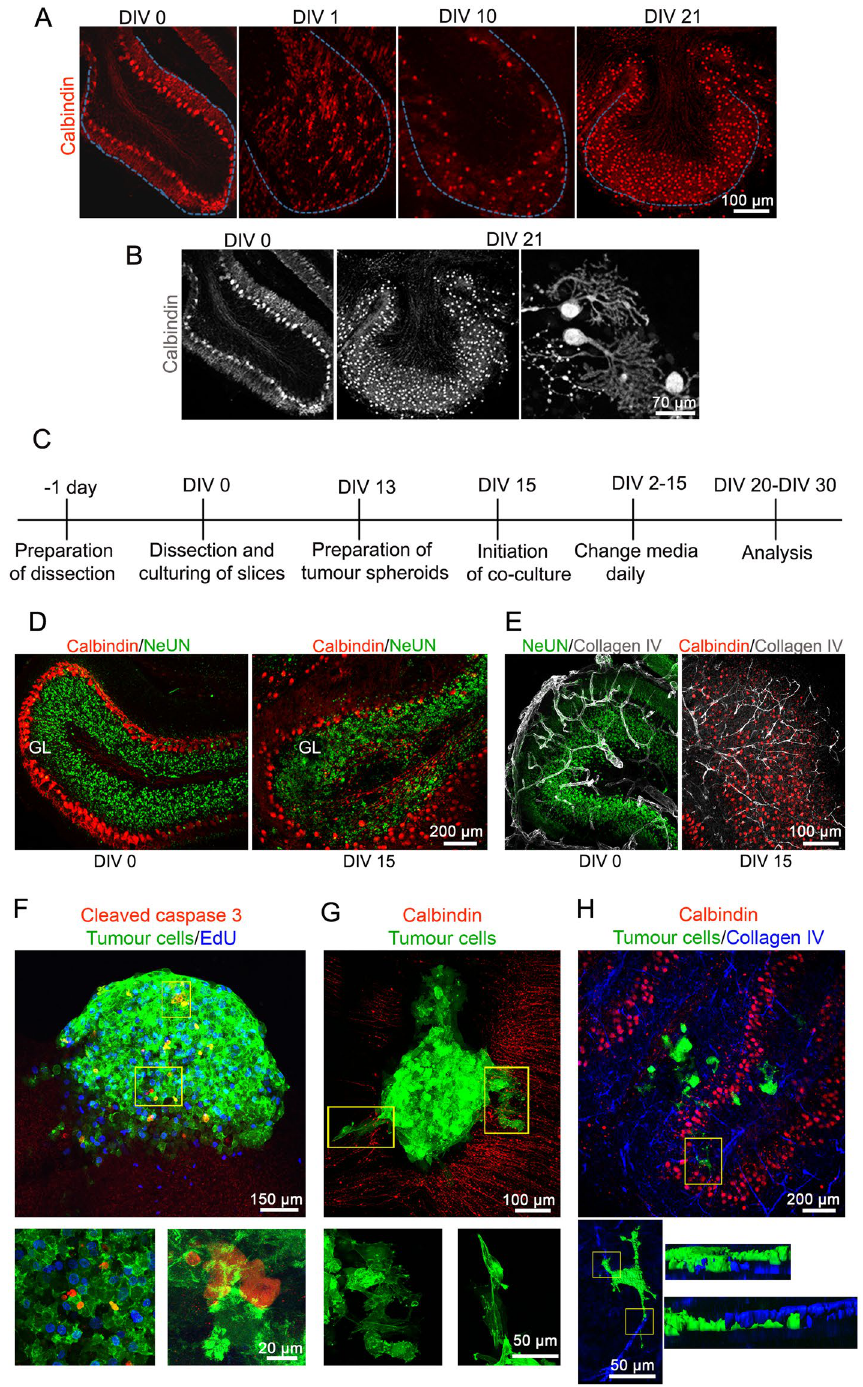
Figure 2. Morphological assessments of the cerebellar slices and co-culture in vitro . ( A) Changes in the Purkinje cell monolayer upon in vitro culturing of the slices was monitored at DIV 0, DIV 1, DIV 10 and DIV 21 with anti-calbindin antibody (red) using confocal microscopy. (B) Grey scale images of cerebellar slices at DIV 0 and after being cultured for DIV 21. ( C) Timeline of the experimental setup for five-day co-culture experiment. DIV 15 was selected as the time point suitable for the implantation of tumour spheroid. ( D) The cerebellar cortex layers visualised using confocal microscopy at DIV 0 and DIV 15 for comparison with anti-Calbindin (red, Purkinje cell layer) and anti-NeuN (green, granular layer) antibodies. ( E) Visualisation of the vasculature using anti-collagen IV (grey) at DIV 0 and DIV 15. ( F) Determination of apoptosis and proliferation after five-day co-culture using anti-cleaved caspase 3 (red) and Click-iT EdU (blue), respectively. ( G) Monitoring the tumour cells infiltrating the cerebellar slices. ( H) Visualization of the vasculature (blue) in the presence of tumour cells. Lower panels: zoomed versions of boxed insets in F, G and H respectively. In H, EGFP and Collagen IV fluorescence was